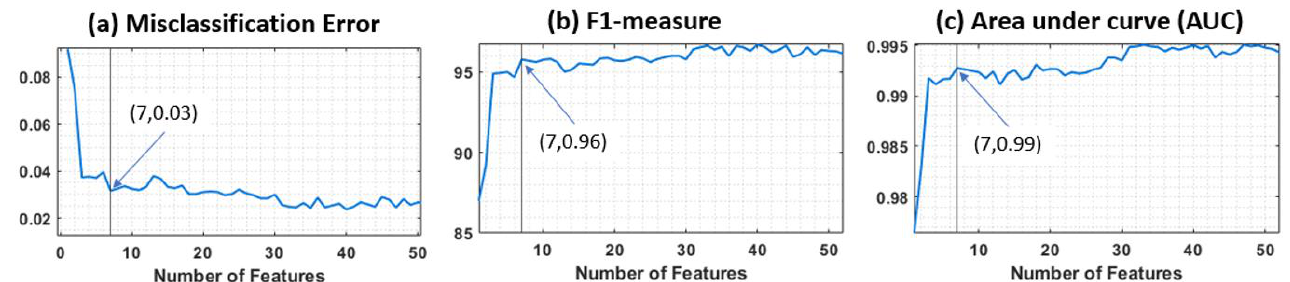
Figure 6. The performance versus the number of features based on the development dataset. ( a ) Misclassification error (MCE), ( b ) F1-measure, and ( c ) area under receiver operating characteristic curve (AUC) of the classifier vs. the number of features giving an optimum number of seven features with MCE = 0.03, F1-measure = 0.96, and AUC = 0.99.